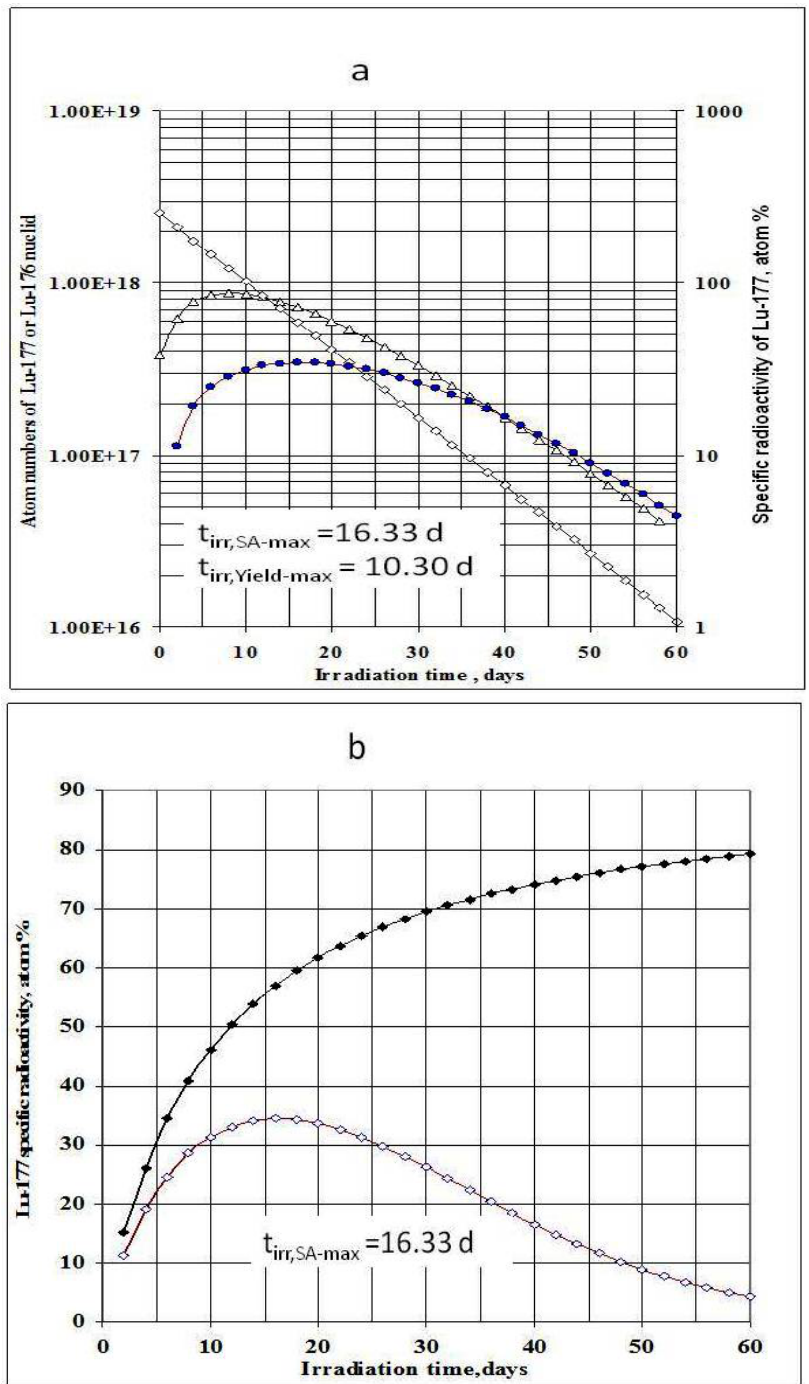
Figure 1. a- 176 Lu target nuclide depression, 177 Lu build-up and 177 Lu specific radioactivity in the 176 Lu enriched target vs . irradiation time (Thermal neutron flux: 1214 105.2   scmn ; Target composition: 74.1% 176 Lu + 25.9% 175 Lu; Target weight: 1.0 mg), 